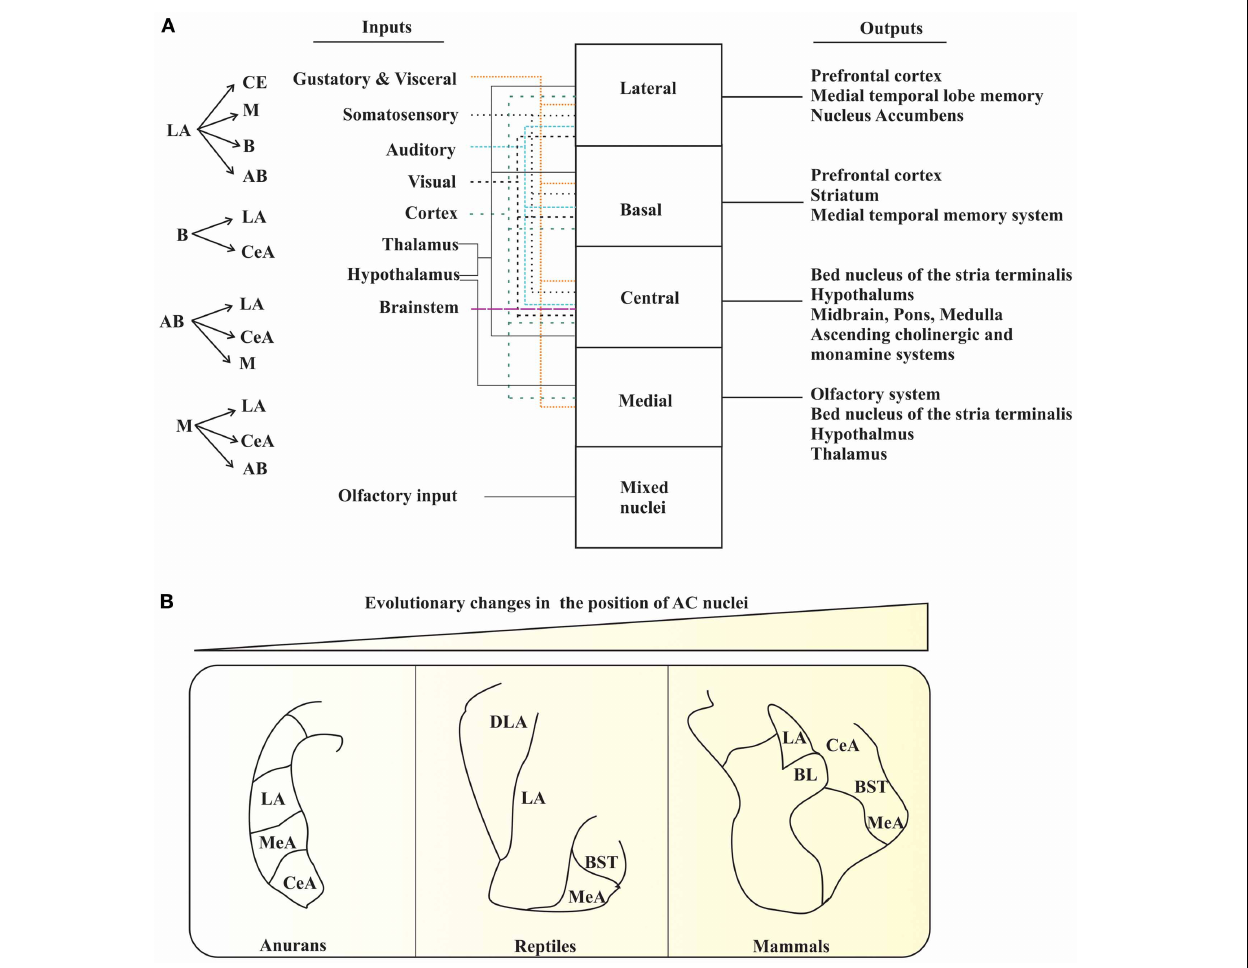
FIGURE 1 | AC of tetrapods. (A) The interconnections ( left panel ) and summary of the main inputs to AC and outputs from AC ( right panel ). The various types of inputs to AC are denoted with different types of colored arrows. (B) Pictorial diagram depicting the changes in the position of certain AC nuclei during the course of